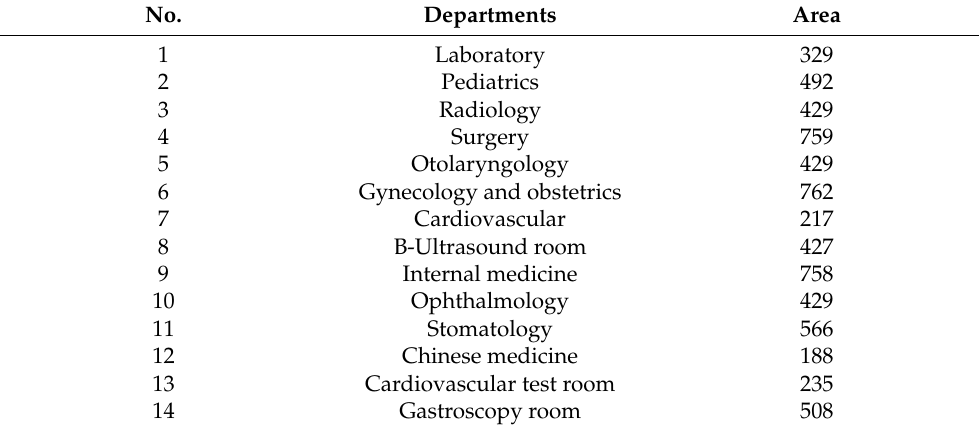
Table 4. Outpatient departments information.